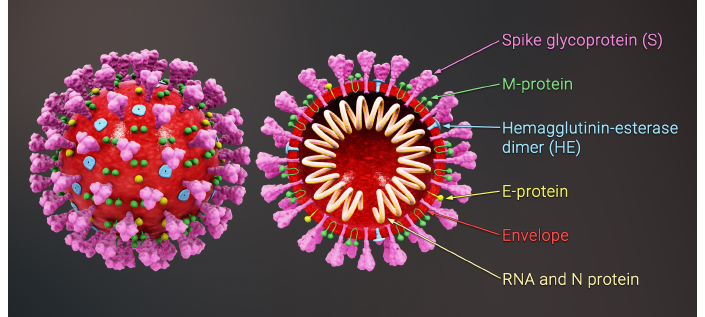
Figure 1. Schematic view of the structure of a coronavirus. The figure shows the structural proteins: Spike (S) proteins (magenta), Membrane (M) proteins (green) and Envelope (E) proteins (yellow). The complex of genome and Nucleocapsid (N) proteins (beige) are enclosed in a lipid membrane called an envelope (red). The picture is adapted from https://www.scientificanimations.com/coronavirus-